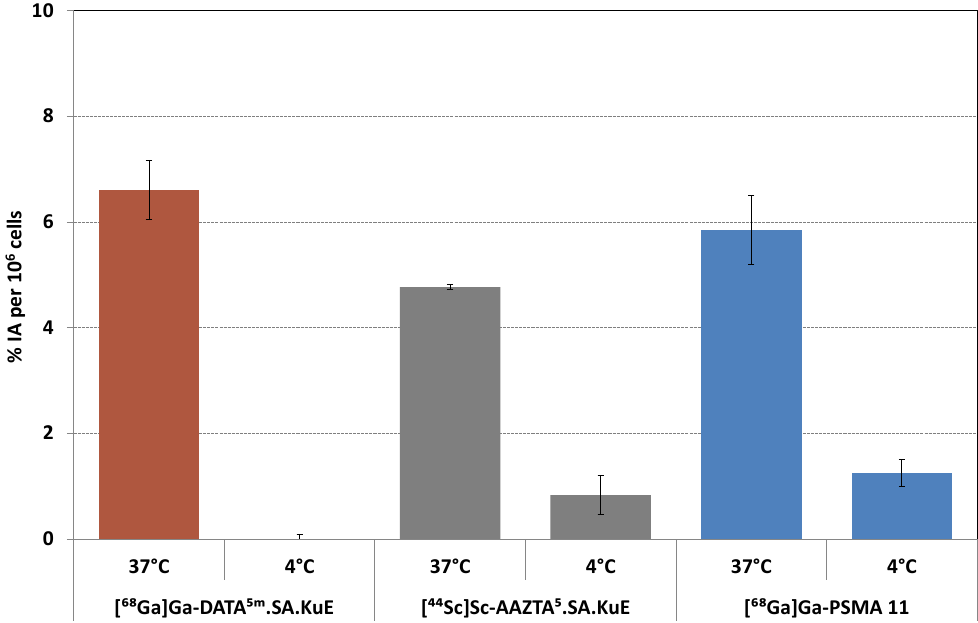
Figure 8. Internalization ratio of [ 68 Ga]Ga-DATA 5m .SA.KuE and [ 44 Sc]Sc-AAZTA 5 .SA.KuE with [ 68 Ga]Ga-PSMA-11 as reference; % injected dose per 10 6 LNCaP cells.